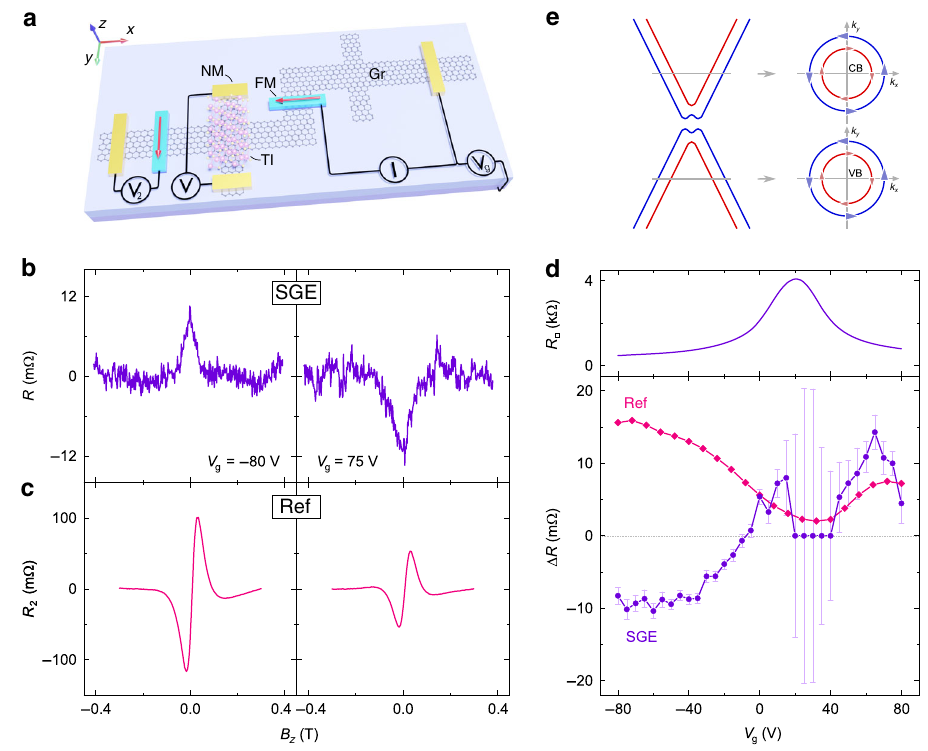
Fig. 3 Gate-controlled sign change of the spin-galvanic signal at room temperature. a A schematic of the device and the measurement geometry. b SGE spin precession signals measured with the Fermi level tuned to the conduction ( V g = 75 V) and valence ( V g = − 80 V) bands of the proximitized graphene. c Reference nonlocal Hanle measurements obtained with the ferromagnetic detector at V g = ±80 V. d Lower panel: The amplitudes of the SGE signal (purple) and scaled (x 0.1) reference Hanle signal (pink) as a function of the gate voltage V g . All the measurements were performed at room temperature with the bias current I = − 500 μ A. Upper panel: Gr – TI channel sheet resistance as a function of the gate voltage, showing a maximum at the charge neutrality point V CNP = 20 V. e A schematic band structure of Gr in proximity to a TI with indicated spin textures of the Rashba spin-split conduction (CB) and valence (VB) bands. Colors represent the helicity of the